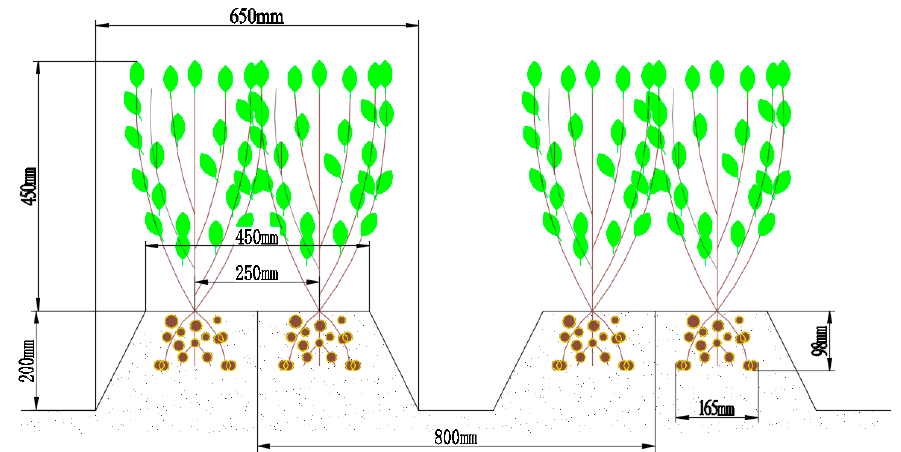
Figure 7. Sketch of the peanut cultivation pattern.